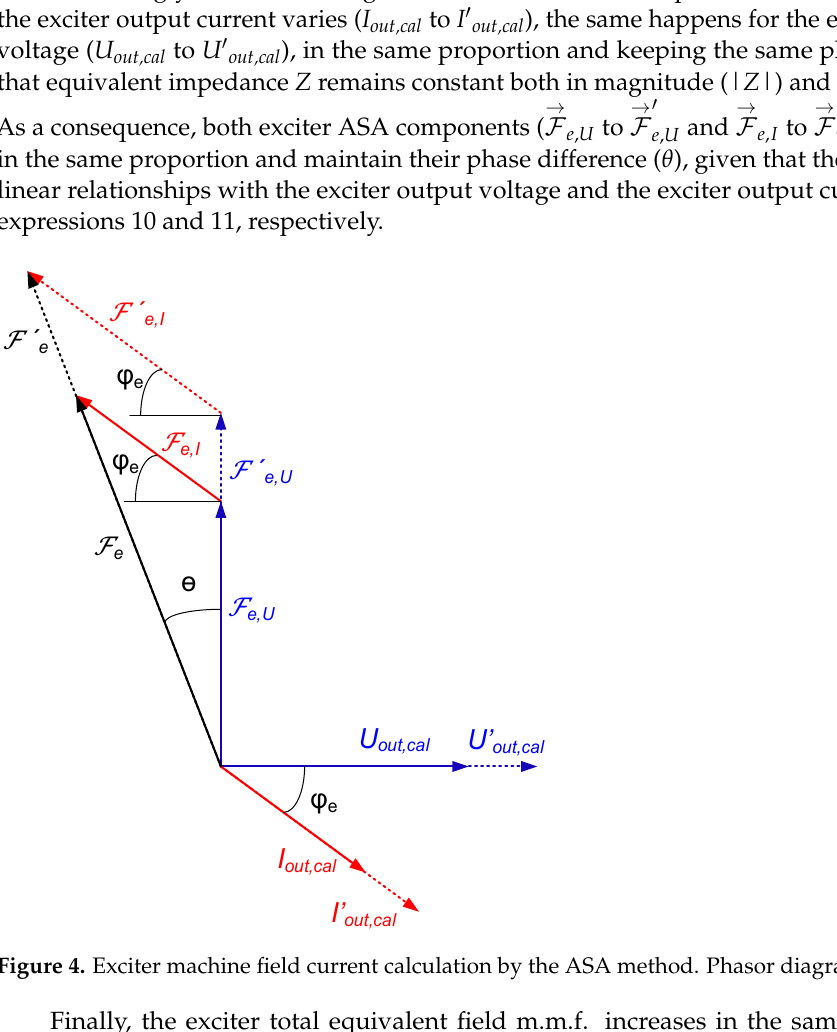
Figure 3. Exciter model (Upper figure: rectifier considered; Bottom figure: equivalent impedance Z simplification). Rotating elements are contained in rectangular sections.